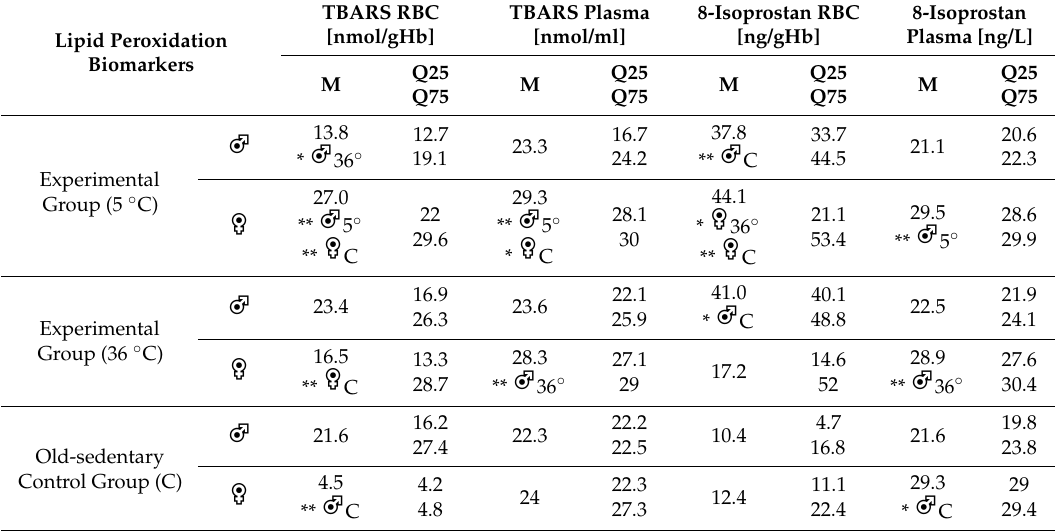
Table 2. Erythrocyte and plasma TBARS and 8-isoprostane concentrations in experimental groups (5 °C and 36 °C), control group and sex-specific differences.